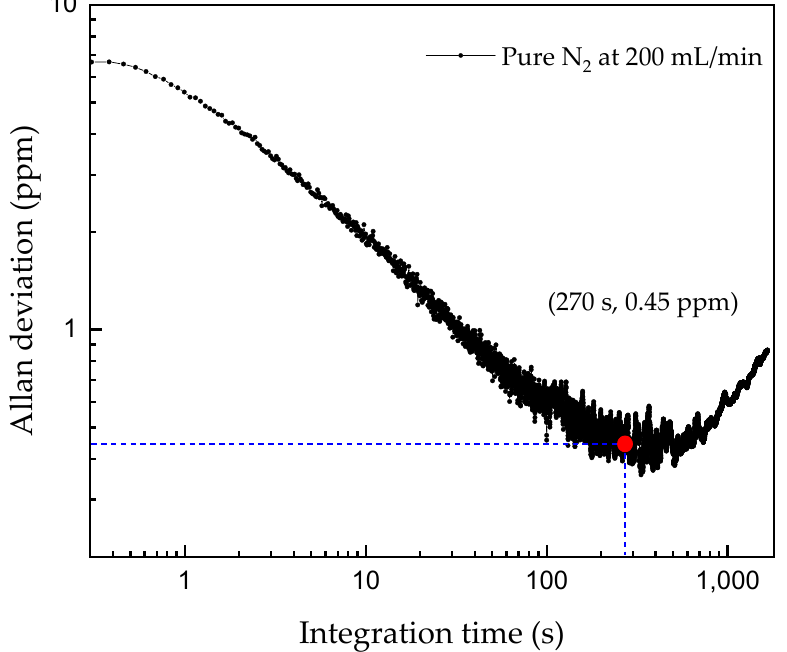
Figure 7. Allan deviation plot in ppm of the quartz enhanced spectrophone as a function of integration time. In the evaluation, basic parameters are analysis time, 140 min; detection bandwidth, 1 Hz; flow rate, 200 mL/min.